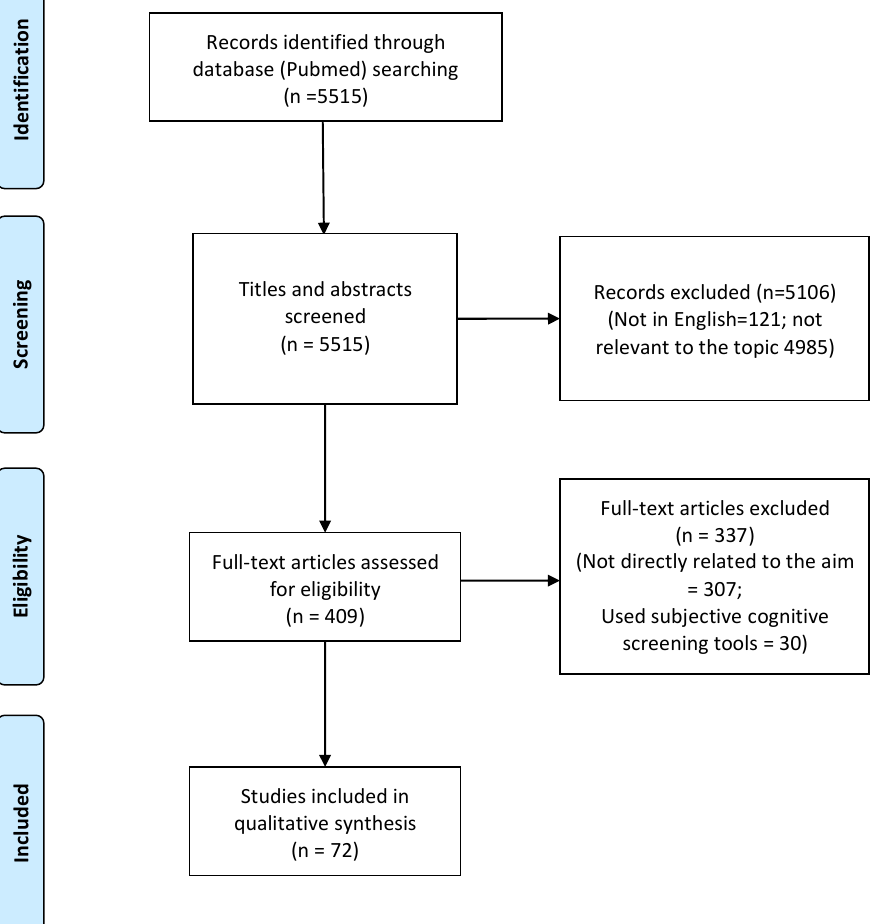
Figure 1. PRISMA flowchart of the included studies.